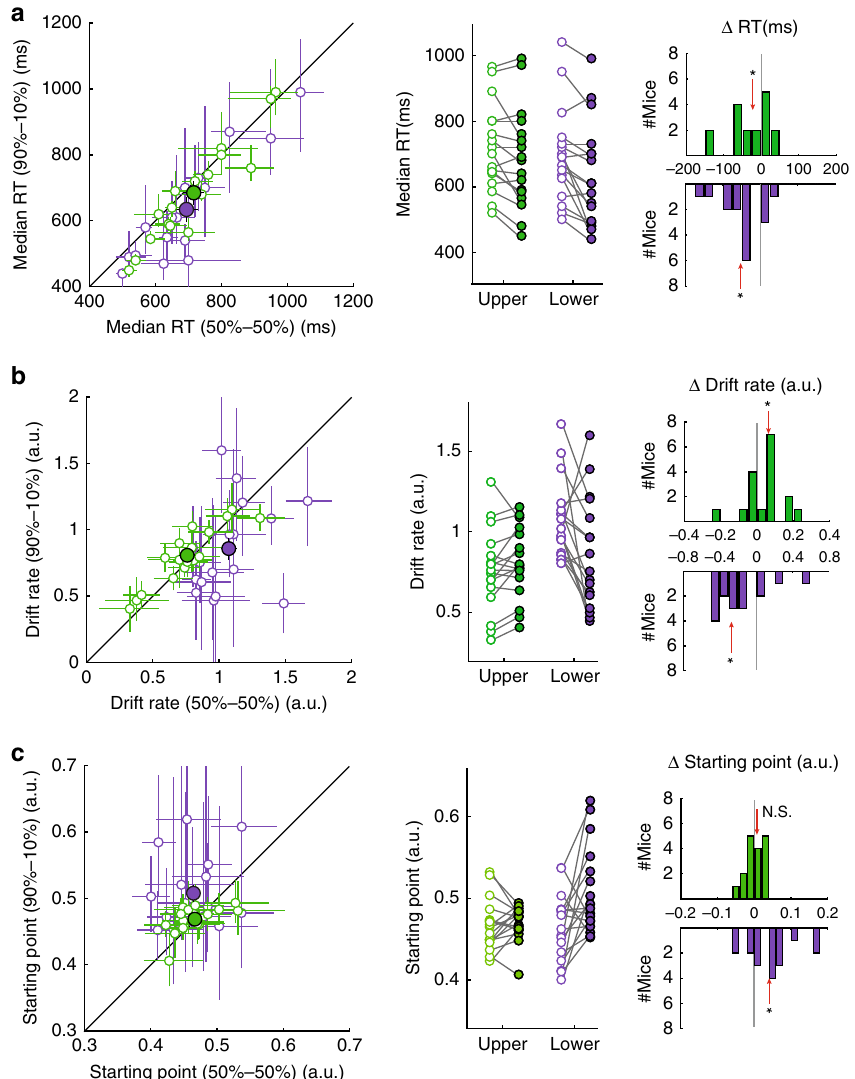
Fig. 2 Spatial probability modulates rate of sensory evidence accumulation in a space-speci fi c manner ( n = 17 mice). a Effect of spatial probability on median reaction time (RT). Left panel: scatter plot comparing the median RT of mice in the 90u-10 condition against the 50 – 50 condition. Each open dot represents one mouse; mean ± 95% con fi dence intervals shown. Green: upper location, purple: lower location. Large fi lled dots: group mean values ± S.E.M. Middle panel: comparison of median RT of each mouse between the 50 – 50 (open dots) and 90u-10 ( fi lled dots) conditions. Right panel: distributions of change in median RT (90u-10 condition minus 50 – 50 condition) derived from middle panel. Upper location: median change = − 20 ms, p = 0.031; Lower location: median change = − 50 ms, p = 0.002. Red arrow: median; asterisk: p < 0.05; two-sided signed-rank and HB tests (see Methods). b , c Drift- diffusion modeling of RT distributions from spatial probability task; data from each mouse were fi tted to the 4-parameter model, and the best- fi t values of the parameters were obtained for each mouse (see Methods). Shown here are effects on two of the four parameters, conventions as in a : b rates of sensory evidence accumulation (drift rates). Upper location: median change = 0.06 a.u., p = 0.035; Lower location: median change = − 0.26 a.u., p = 0.017. c Starting point. Upper location: median change = 0.01 a.u., p = 0.554; Lower location: median change = 0.04, p = 0.017. N.S. not statistically signi fi cant. See also Supplementary Fig. 2. Source data are provided as a Source Data fi